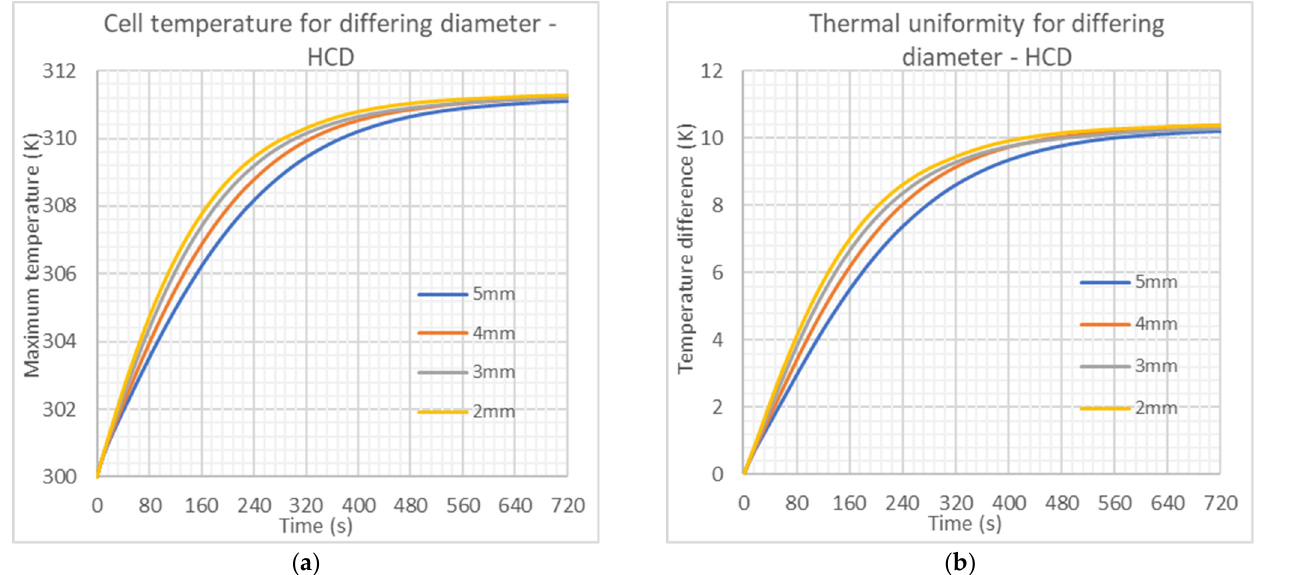
Figure 14. HCD–effects of channel diameter on: ( a ) Maximum cell temperature; ( b ) Cell temperature difference.